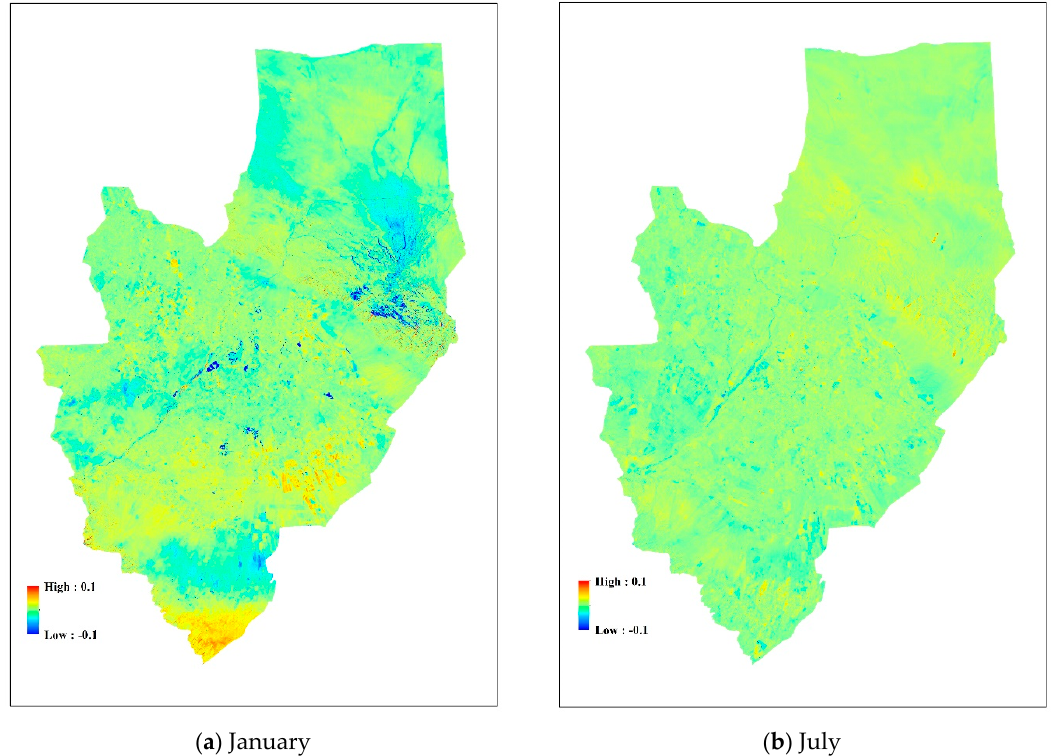
Figure 8. Spatial distribution of annual variation rate of surface albedo in Ganzhou in ( a ) January and ( b ) July from 2014 to 2018.